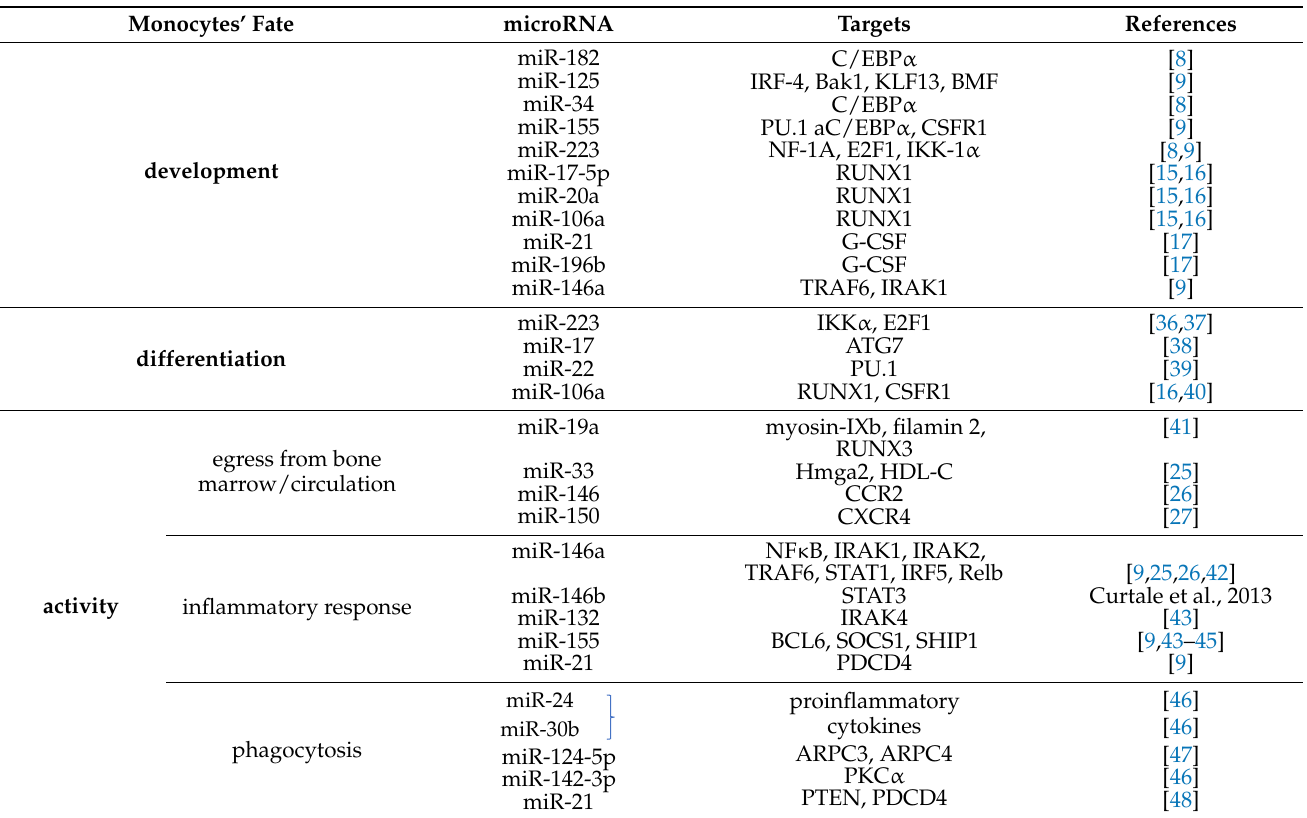
Table 1. miRNA in monocytes’ fate.